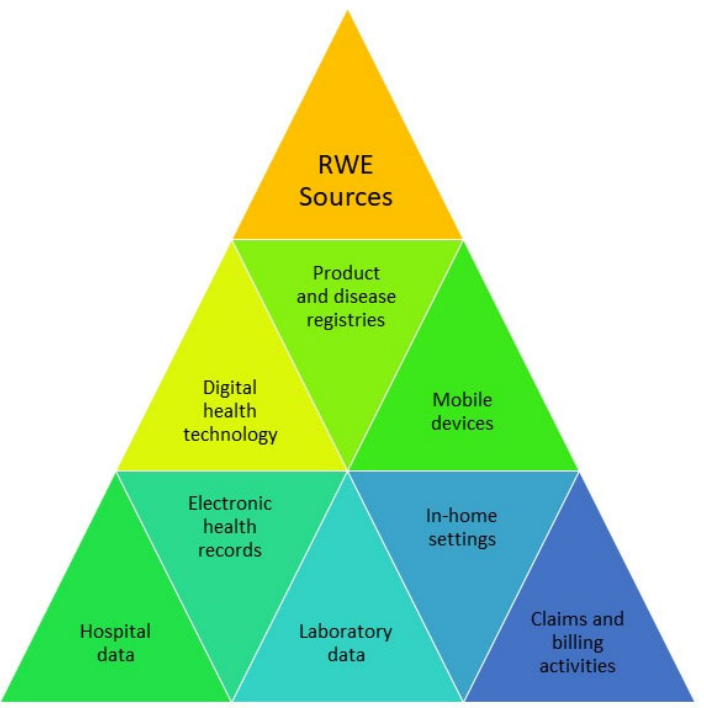
Figure 1. Sources of real-world evidence (RWE) research.